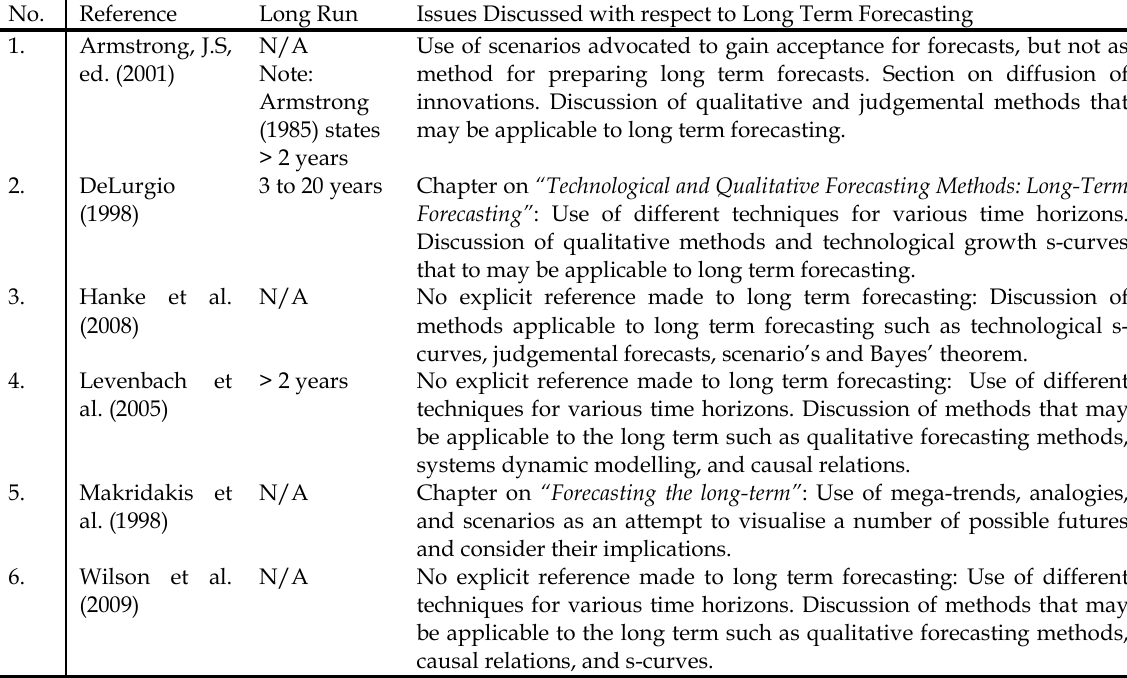
Table 1. Results of Desk Study on Forecasting